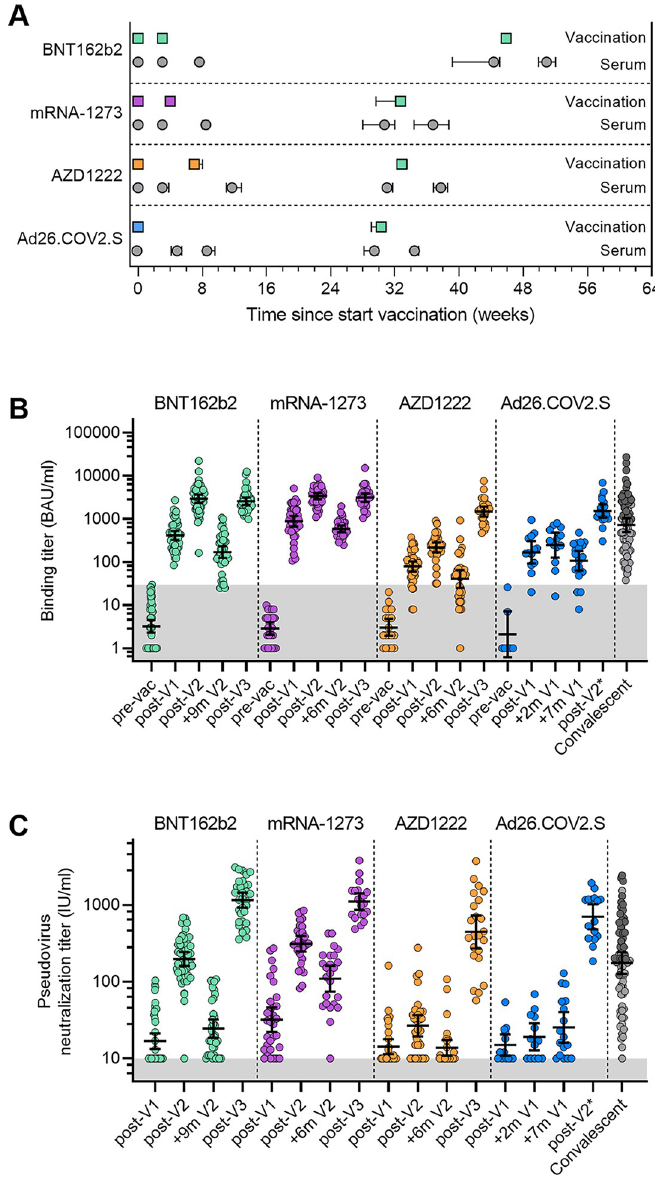
Fig 1. Binding and neutralization titers pre- and post-vaccination with one of the four SARS-CoV-2 vaccines. ( A) Timelines of the vaccinations and serum collections, showing the mean and interquartile range (IQR) of times of vaccination and samples in weeks after the first dose. (B) Binding titers to wild-type S protein (BAU/ml) of 1:100,000 diluted sera collected over time for the four vaccination groups. The convalescent group (n = 67) consists of sera from hospitalized (dark gray) and non-hospitalized (light gray) COVID-19 patients collected 4–6 weeks post symptom onset. Geometric mean titers (GMT) and 95% confidence intervals (CI) are indicated. The lower cutoff for binding was set at 30 BAU/ml (grey shading). (C) Neutralization half-maximal inhibitory concentration (IC 50 ) titers (IU/ml) of D614G pseudovirus for sera collected post-vaccination over time for the four vaccination groups. The convalescent group (n = 67) consists of sera from hospitalized (dark gray) and non-hospitalized (light gray) COVID-19 patients collected 4–6 weeks post symptom onset. GMT and 95% CI are indicated. The lower cutoff for neutralization was set at an IC 50 of 10 or for Omicron at 2 IU/ml (grey shading). Pre-vaccination (pre-vac), 3–4 weeks post-first vaccination (post-V1), 4 weeks post-second vaccination (post-V2), 6 or 9 months post-second vaccination (+6m V2 or +9m V2) and 4 weeks post-booster vaccination (post-V3) serum samples are shown. As the Ad26.COV2.S vaccine uses a single- dose regime, 2 and 7 months post-first vaccination are taken as comparisons and the BNT162b2 booster vaccination is vaccination number two (post-V2 � ). All data points shown here represent the mean of a technical triplicate. Uni- and multivariable linear regression analysis with GMT and 95% CI results indicated in S4 Table.